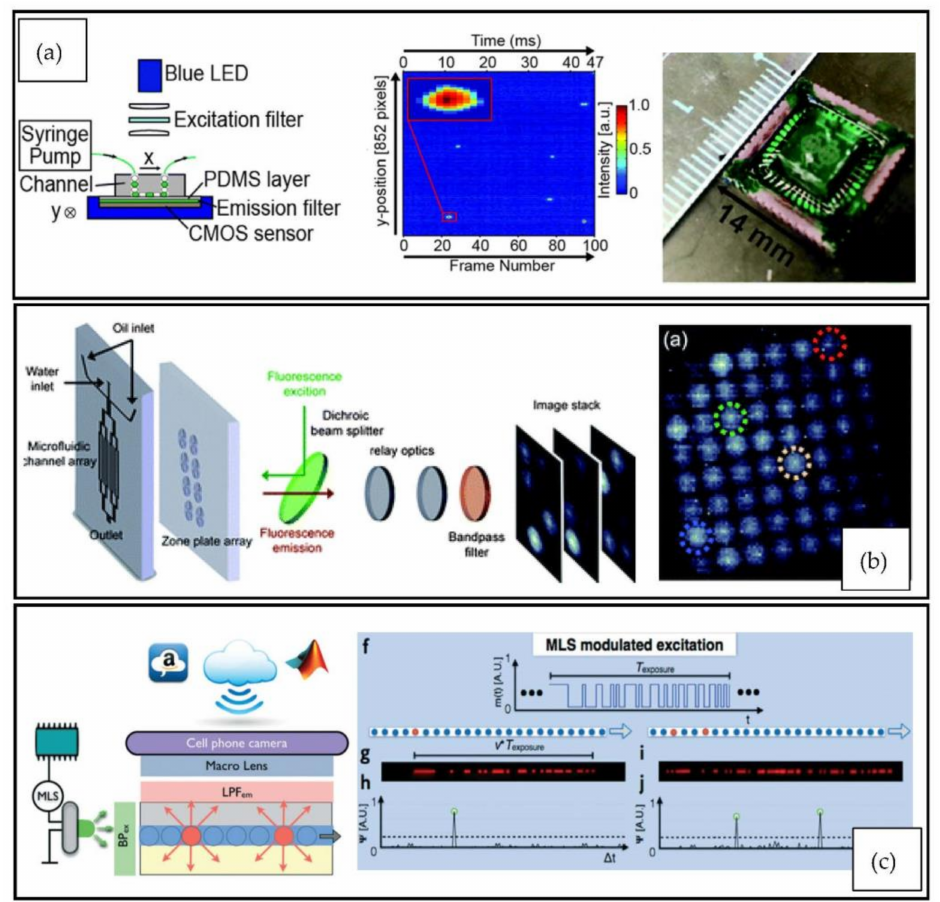
Figure 6. Demonstrated ultrahigh-throughput detection setups in DMFC. ( a ) A compact LED-CMOS system, which could detect fluorescent droplets at 254,000 dps throughput. The system used a simple and compact optical path and microfluidic channels branching into 16 parallel channels to increase throughput [72]. ( b ) A laser-CMOS system, which could detect droplets at 184,000 dps throughput. In this application, microfluidic channels were split into 64 parallel branches and imaged through an 8 × 8 zone-plate array. The resultant image is shown on the right [80]. ( c ) An LED-CMOS system capable of detecting droplets at up to 1,000,000 dps throughput. This was achieved by splitting the microfluidic channels into 120 parallel branches. Additionally, pseudorandom maximum length sequences (MLS) were used for excitation that prevented droplets overlapping due to framerate limitations of CMOS cameras [77]. Reproduced with permission from